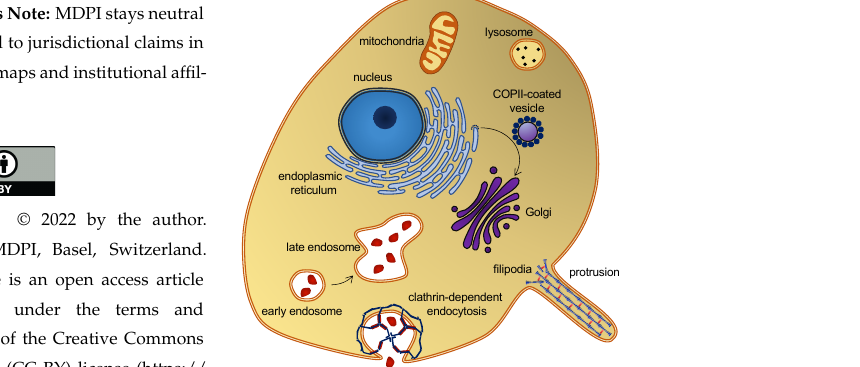
Figure 1. Eukaryotic cell and organelles, with examples of various membrane curvatures. Some curvature-inducing proteins are also shown, see the main